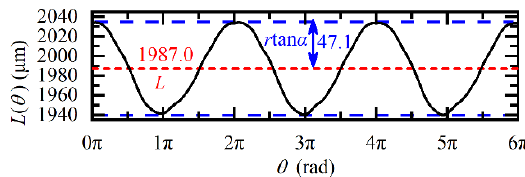
Figure 5. Variation of the actual distance L ( θ ) under the condition of Ω = 0 rad/s.